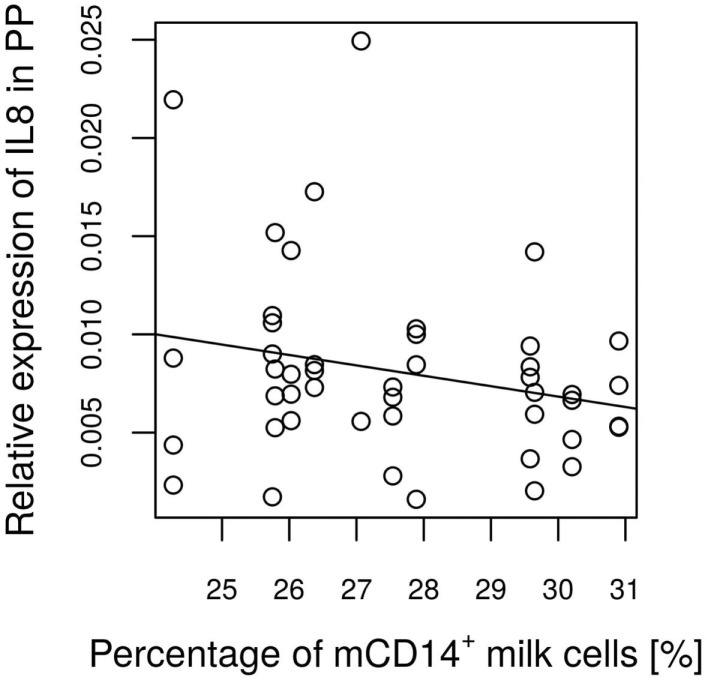
Expression of IL-8 in relation to a basal CD14 value of the attendant sow milk at every time point measured. The linear regression coefficient between IL-8 expression and the basal CD14 value indicate a tendency (P = 0.136) for a negative relationship.